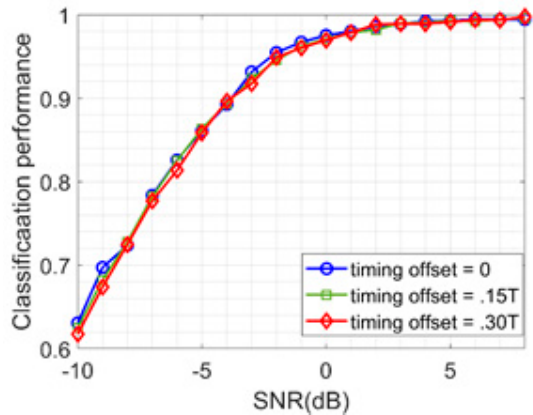
Figure 12. The Performance of NSVM with Different Timing Offsets.